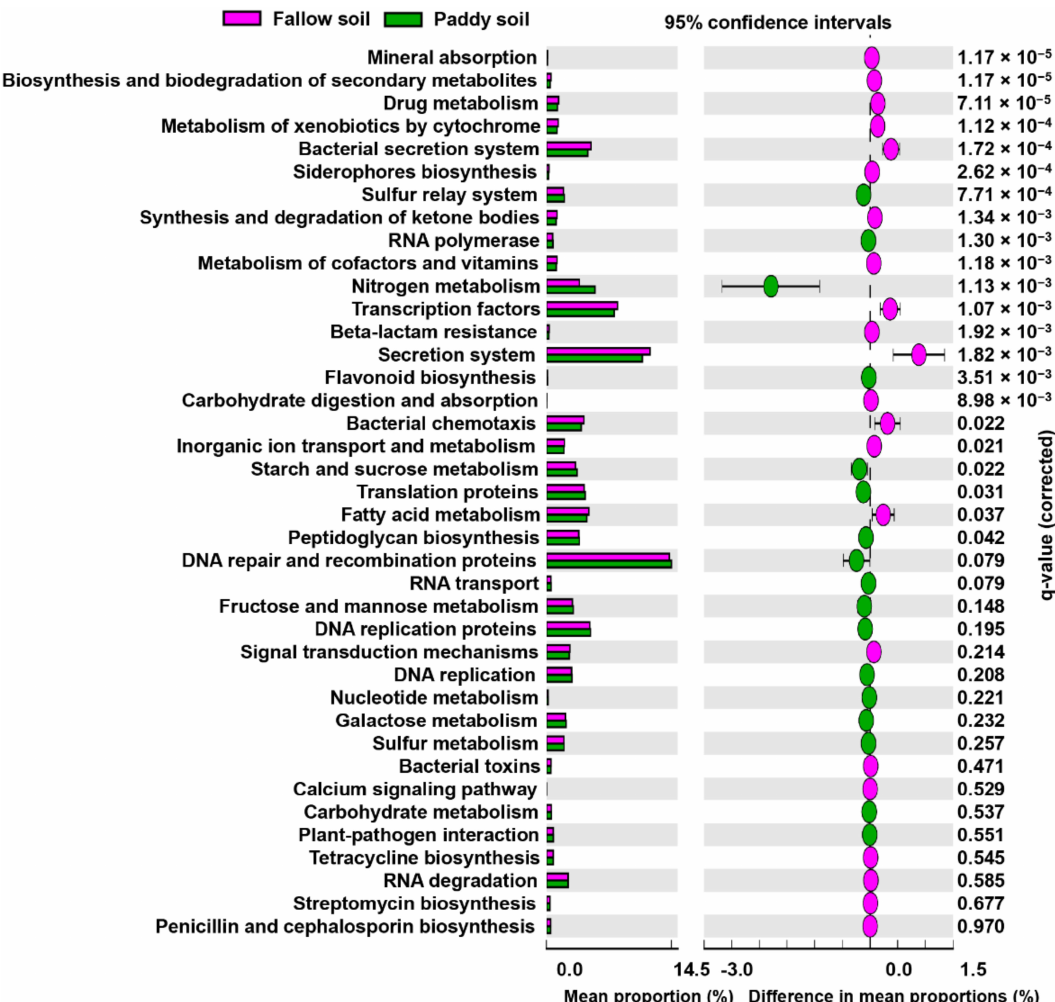
Figure 5. Extended error bar plot illustrating the mean proportion (%) significantly different func- tional groups at KEGG level 3. Points represent differences between the fallow and paddy soil (pink and green). Welch’s t -test was performed with a Benjamini–Hochberg FDR test correction to calculate q